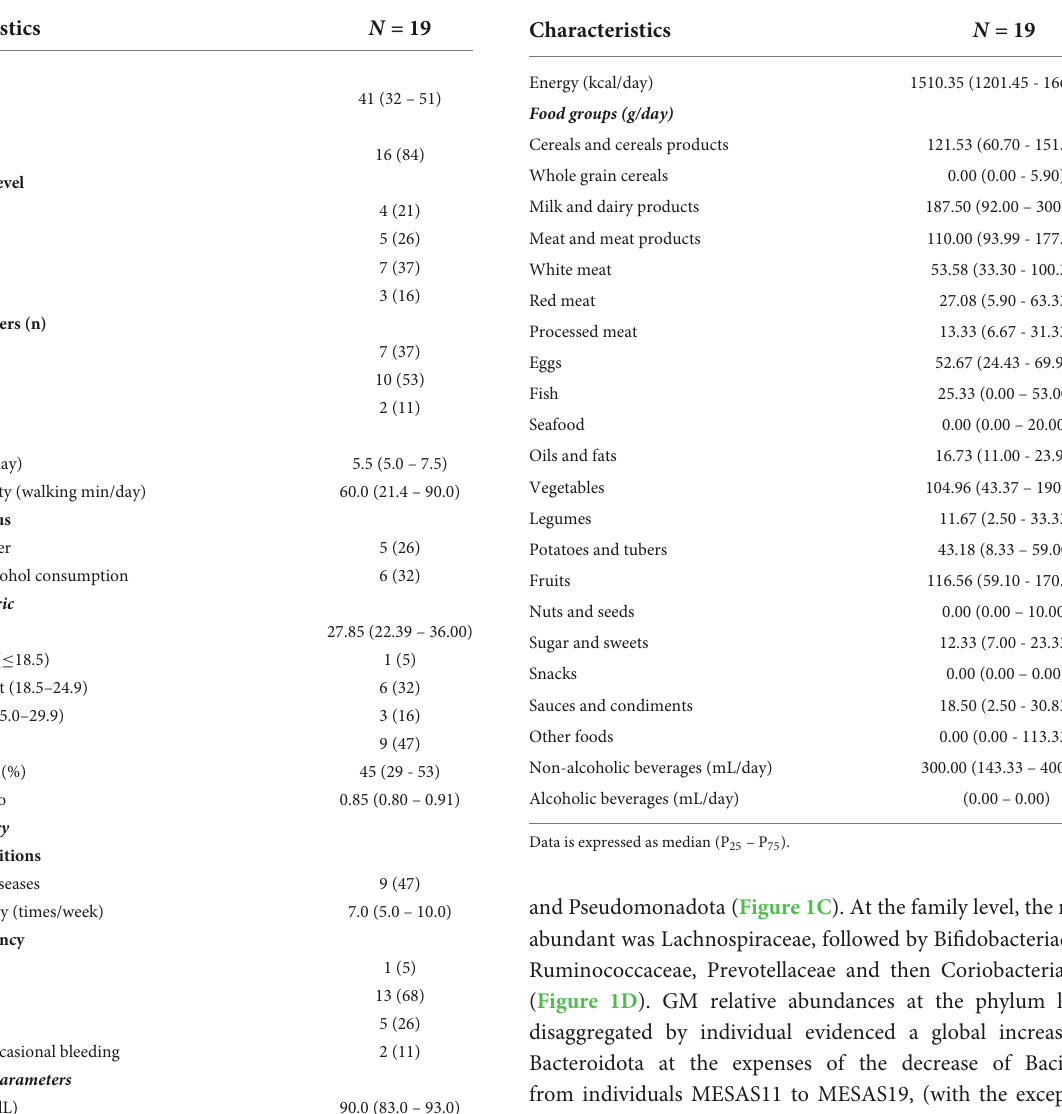
TABLE 1 General characteristics and clinical history of the sample population.